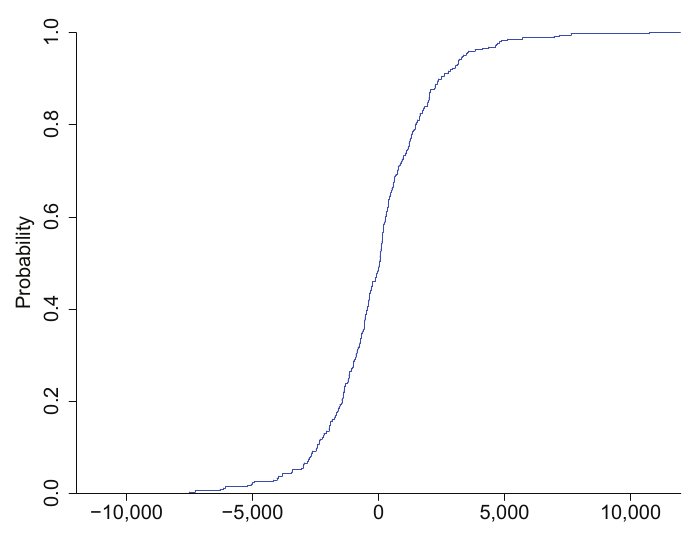
Figure 3. Empirical cumulative distribution function of the centered residuals ˜ e t .